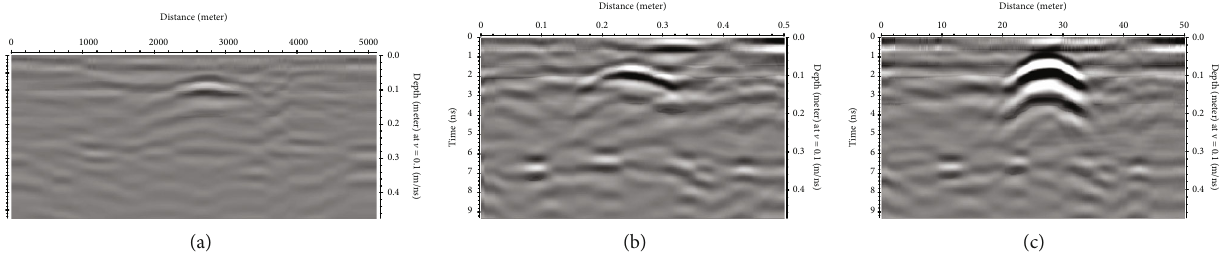
Figure 3: Air pipe (a), plastic pipe (b), and metal pipe